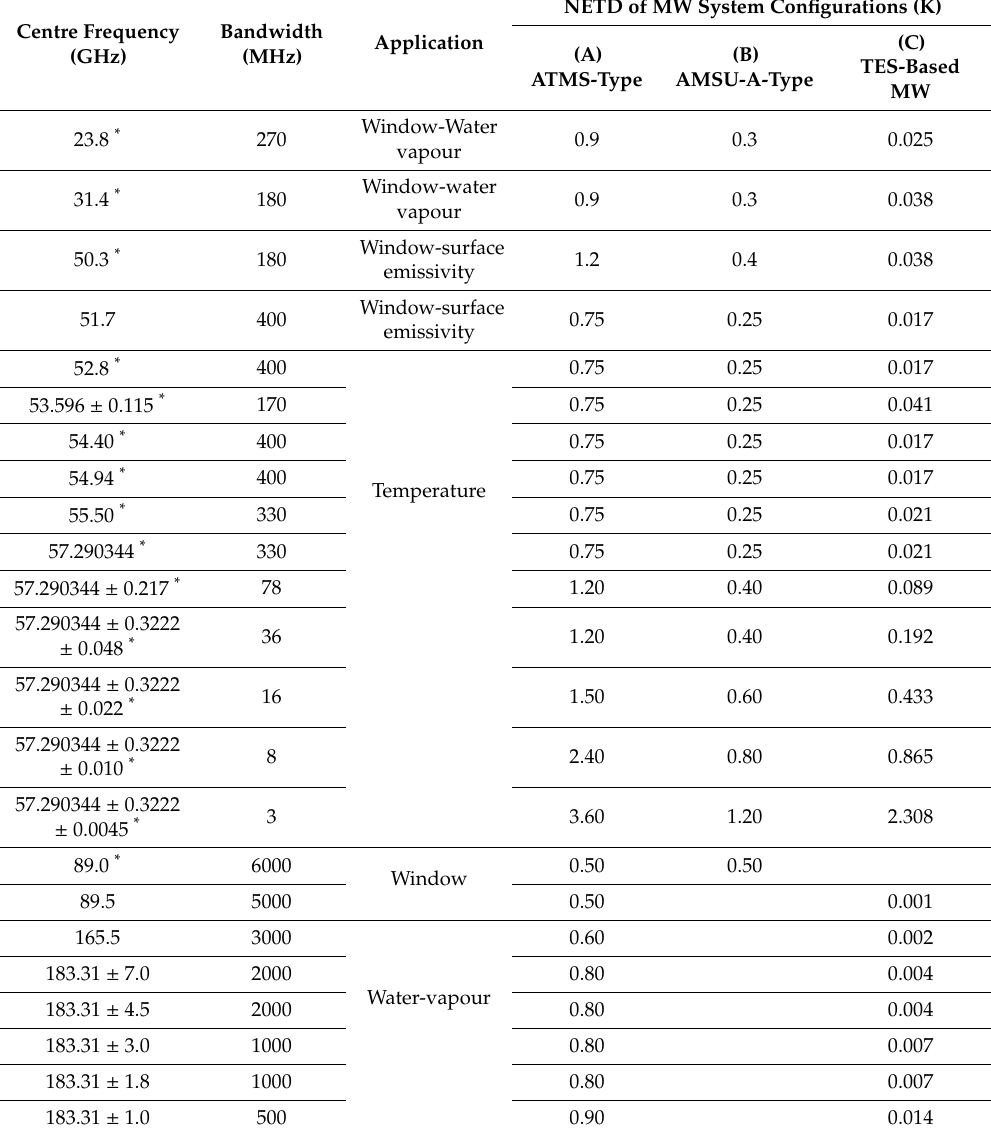
Table 2. Spectral and radiometric specifications of set up MW system configurations A, B and